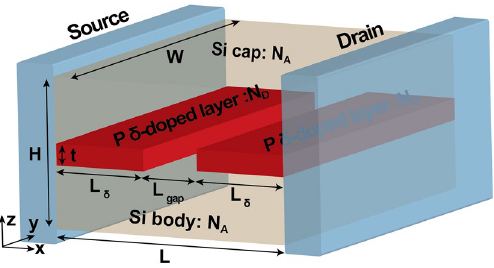
Figure 1. Geometry of the Si:P δ -layer tunnel junction. Our device consists of a semi-infinite source and drain, in contact with the engineering channel. The channel is composed of a lightly doped Si body and Si cap and a very thin, highly P doped-layer with an intrinsic gap of length L gap